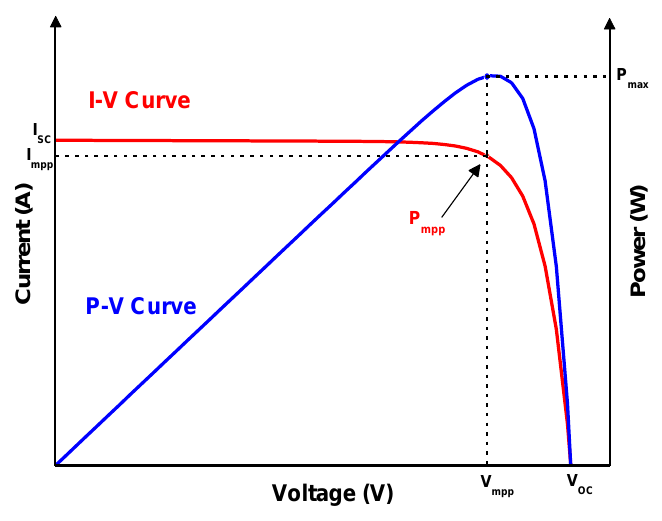
Figure 2. PV cell curve characteristics.